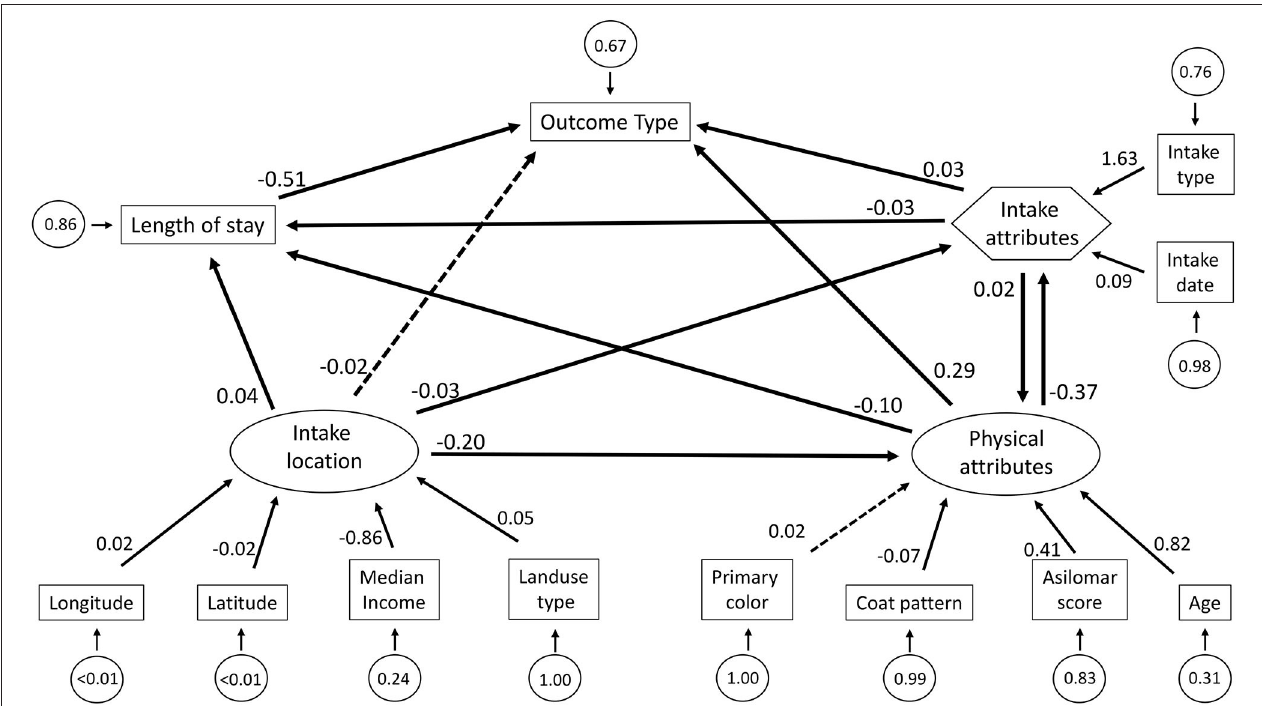
FIGURE 2 | The structural equation model describing our global model predicting cat outcomes. Arrows describe the direction of effect. Solid black arrows are statistically significant at α = 0.05, dotted arrows indicate a lack of statistical significance. Numbers alongside the arrows are standardized path coefficients (beta coefficients). Measured variables are depicted in rectangles, latent variables are depicted in ovals, and composite variables are depicted in hexagons. The error terms, which describe the variance of the associated term, are in circles. Possible outcome types are adoption, death/euthanasia, and return to field. Based on how they were coded, negative coefficients indicate an increased likelihood of adoption and positive coefficients indicate a decrease in likelihood of